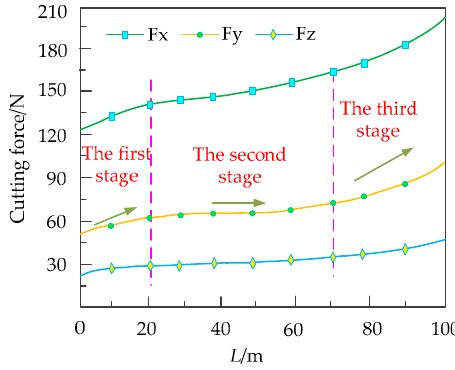
Figure 5. The milling force curves of staggered PCD cutter due to variations in milling length.